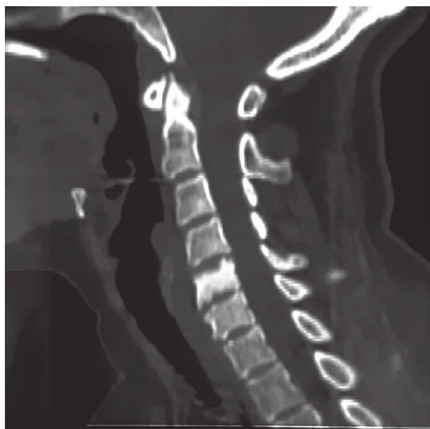
Figure 1: Sagittal reconstruction (bone window) shows the aspect of an ivory C5